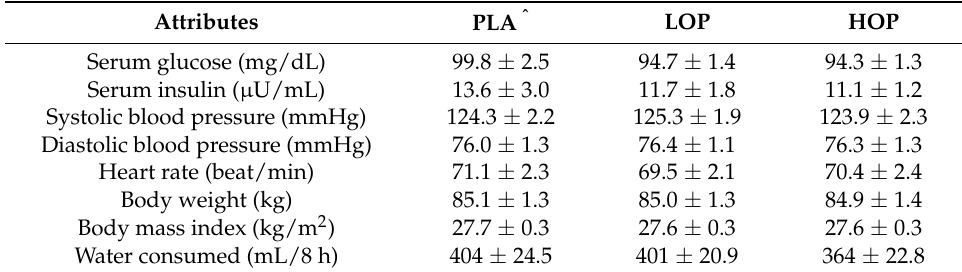
Figure 1. CONSORT flow diagram of the progress through the phases of a randomized, 3 ‐ way crossover, pharmacokinetics trial. Table 2. Demographics of the study participants at the baseline of each intervention visit *.